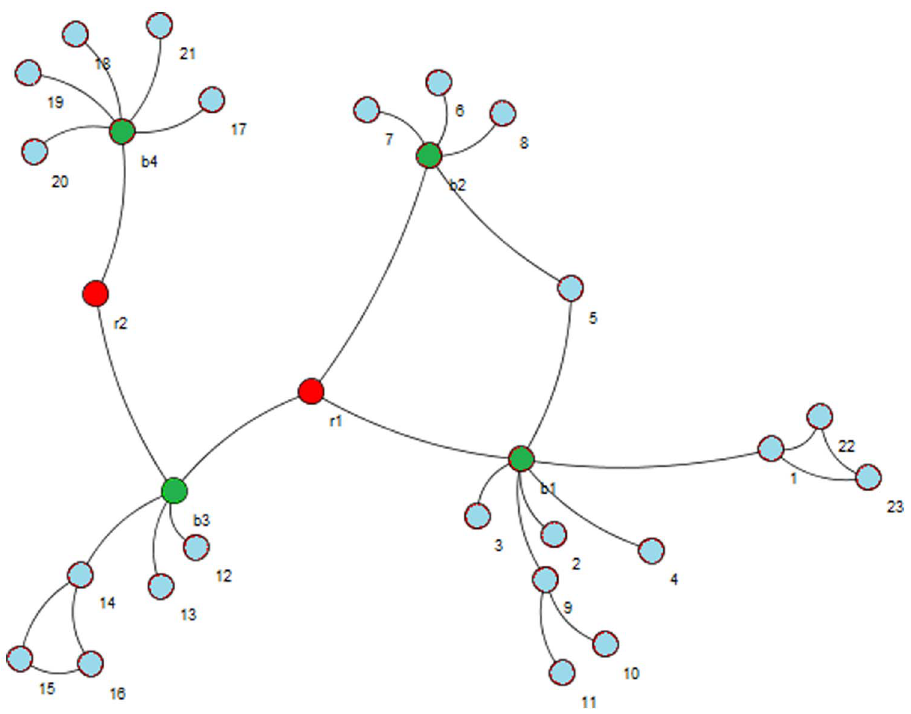
Figure 2. Two red vertices A and A ’ are creative elements and green vertices are hubs. The original network can be found in [ 27 ] .